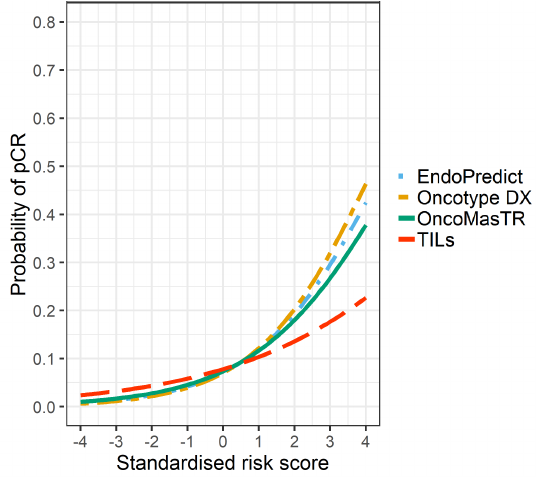
Figure 3. Predicted probability of pCR by risk score in 7 datasets (5 datasets missing